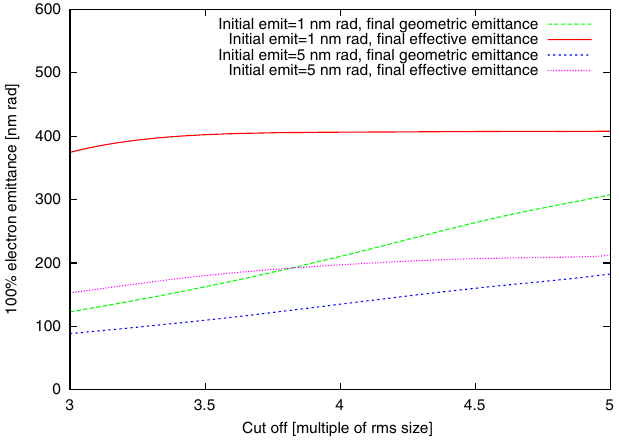
FIG. 8. (Color) 100% electron geometric and effective emittance as a function of cutoff points for Gaussian distribution, for a large (initial rms emittance ¼ 5 nm rad ; (cid:6) (cid:5) ¼ 0 : 2 m ) and a small initial emittance (initial rms emittance ¼ 1 nm rad ; (cid:6) (cid:5) ¼ 1 m ).